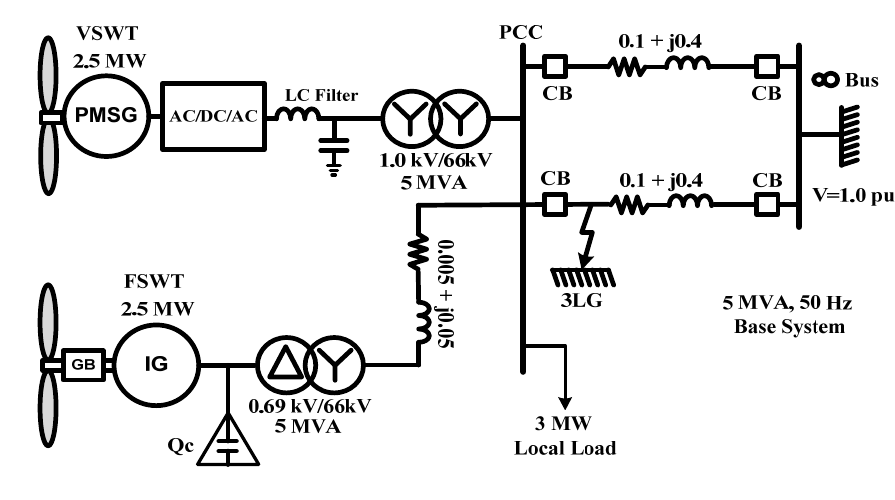
Figure 20. Wind farm